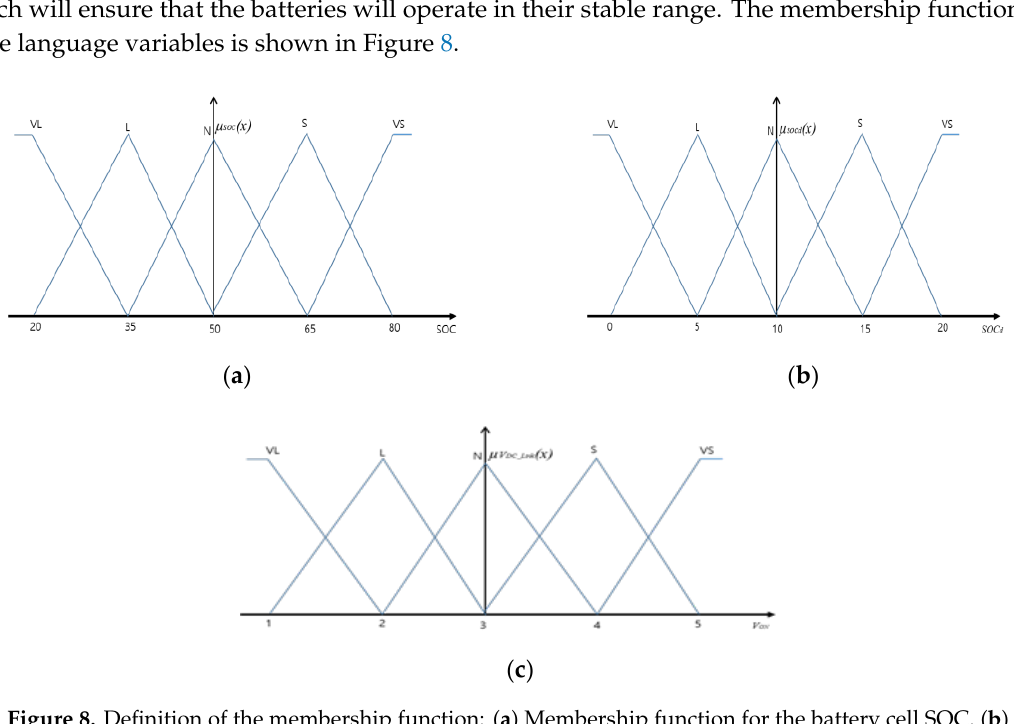
Figure 8. Definition of the membership function: ( a ) Membership function for the battery cell SOC. ( b ) Membership function for the SOC di ff erence between battery cells. ( c ) Membership function for the output Von of the